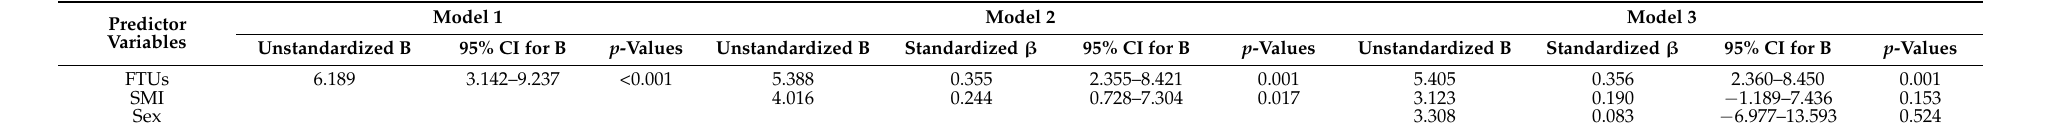
Table 4. Factors associated with mixing ability index.